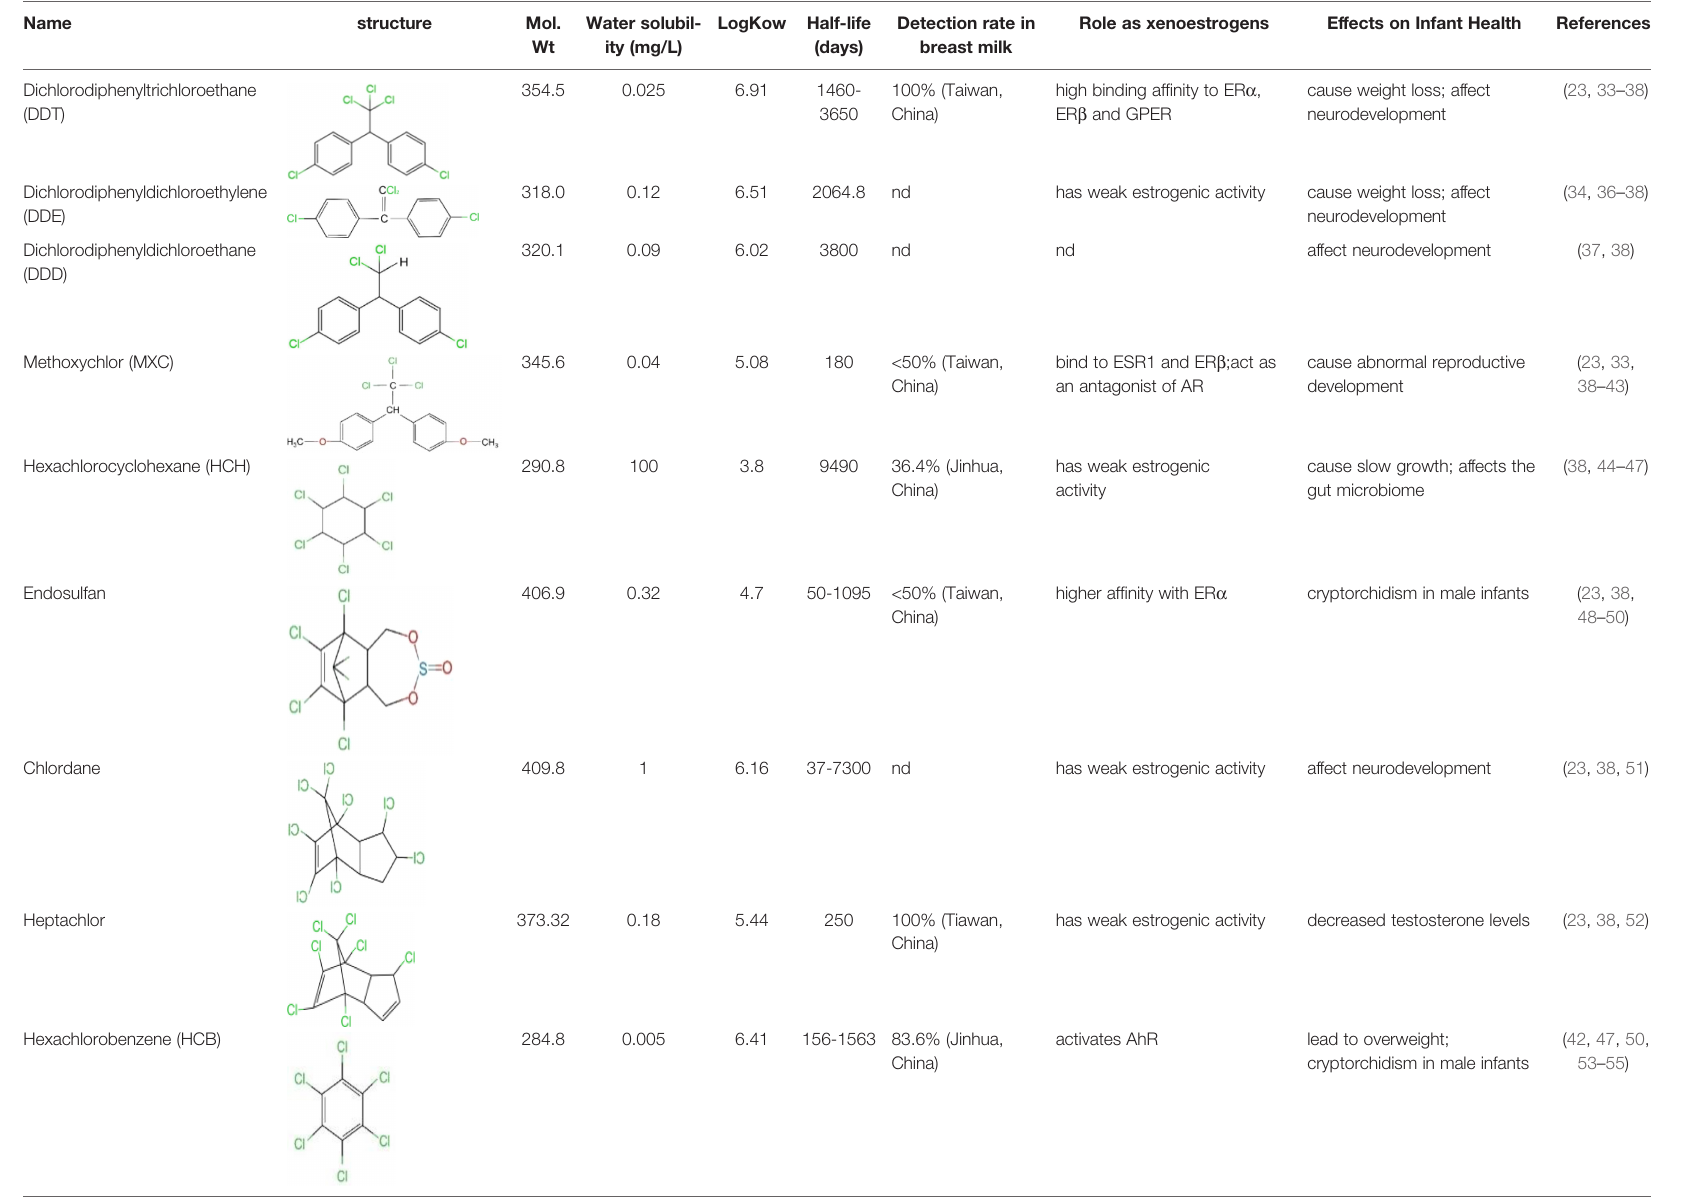
TABLE 1 | Structure, physicochemical properties and biological effects of several organochlorine